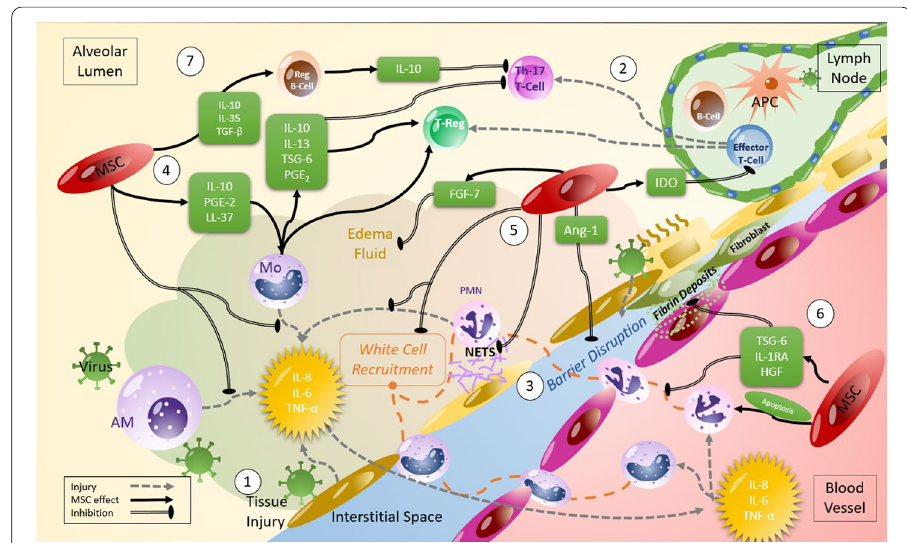
Fig. 1 Mechanisms of action of MSCs which can counteract viral infection. (1) Viral infection leads to tissue damage at the delicate blood-air barrier in the lung. The release of inflammatory cytokines initiates further tissue damage with (2) inflammatory T-cell proliferation and differentiation to Th-1 and Th-17s, (3) inflammatory white cell recruitment from the blood and tissues leading to further inflammation, creation of neutrophil NETS, fibroblast differentiation, oedema fluid accumulation and significant barrier disruption. MSCs have been demonstrated to act on several of the injurious processes that occur in infection such as (4) Release of cytokines and chemokines which promote anti-inflammatory innate and adaptive cell phenotypes, (5) release of factors which prevent the formation of NETS, reduce barrier disruption, and (6) prevent fibroblast differentiation and promote PMN apoptosis. (7) MSC IL-10 production and production from anti-inflammatory monocytes induces regulatory B and T cells and promotes tissue protection and repair, and MSC IDO production regulates inflammatory T-cell